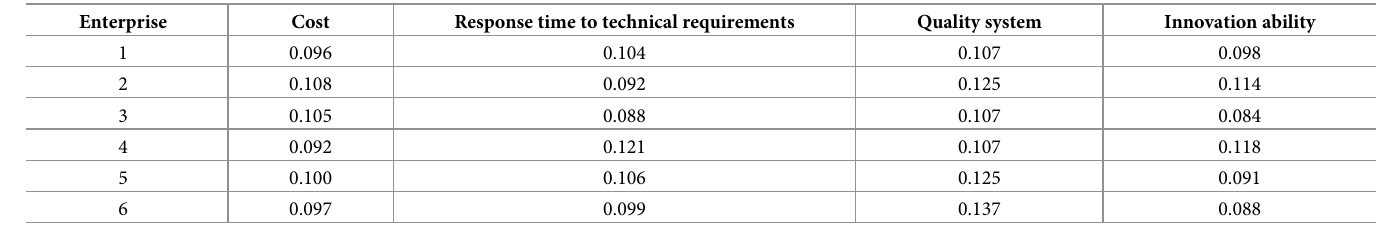
Table 3. Post-specification point values for technology candidate enterprises.